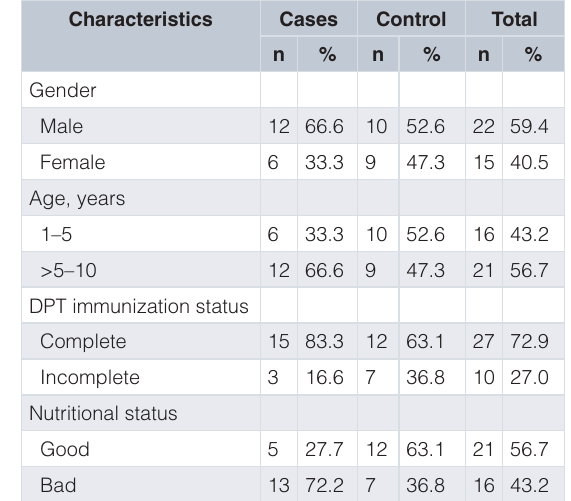
Table 1. Characteristics of respondents